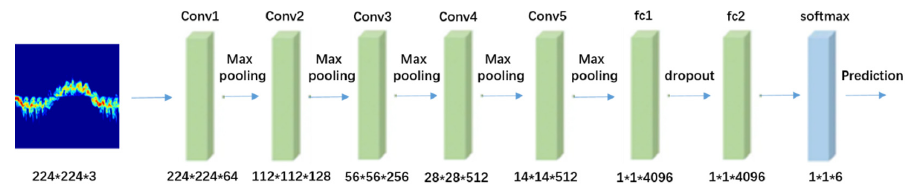
Figure 1. The improved VGG16 Model.